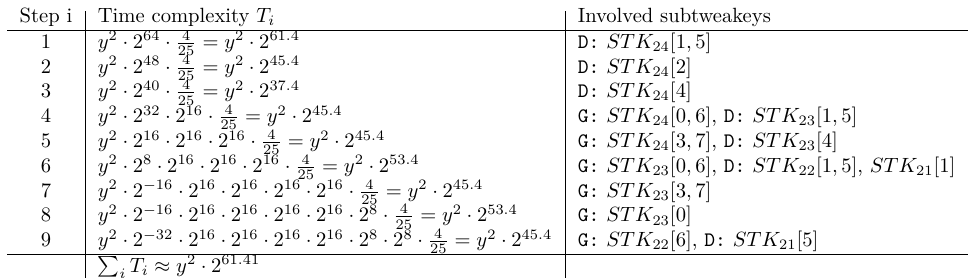
Table 11: Time complexity and guessed subtweakeys of each step in the tweakey recovery process for 25-round SKINNY-128-256 . D: deduced key cells; G: guessed key